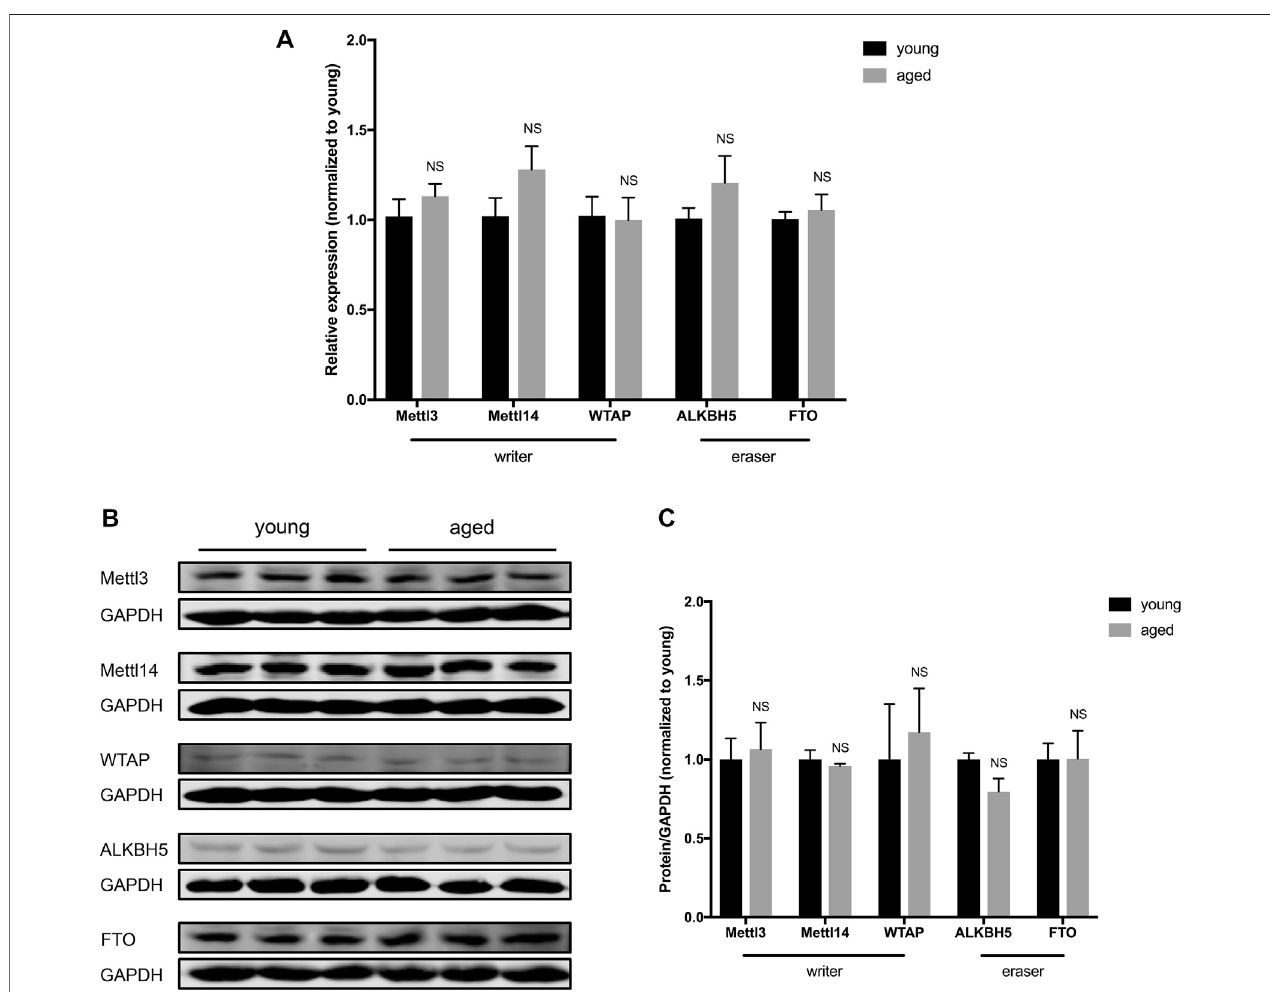
FIGURE 2 | Expression of m6A RNA methylases and demethylases in the heart did not differ according to age. (A). Quanti fi cation of mRNA for m6A RNA methylases and demethylases, n (cid:1) 5. (B) . Representative immunoblotsfor m6A RNA methylases and demethylases. (C) . Densitometry quanti fi cation ofprotein for m6A RNA methylases and demethylases, n (cid:1) 3. Results are presented as mean ± standard error of the mean (SEM). NS, p > 0.05.